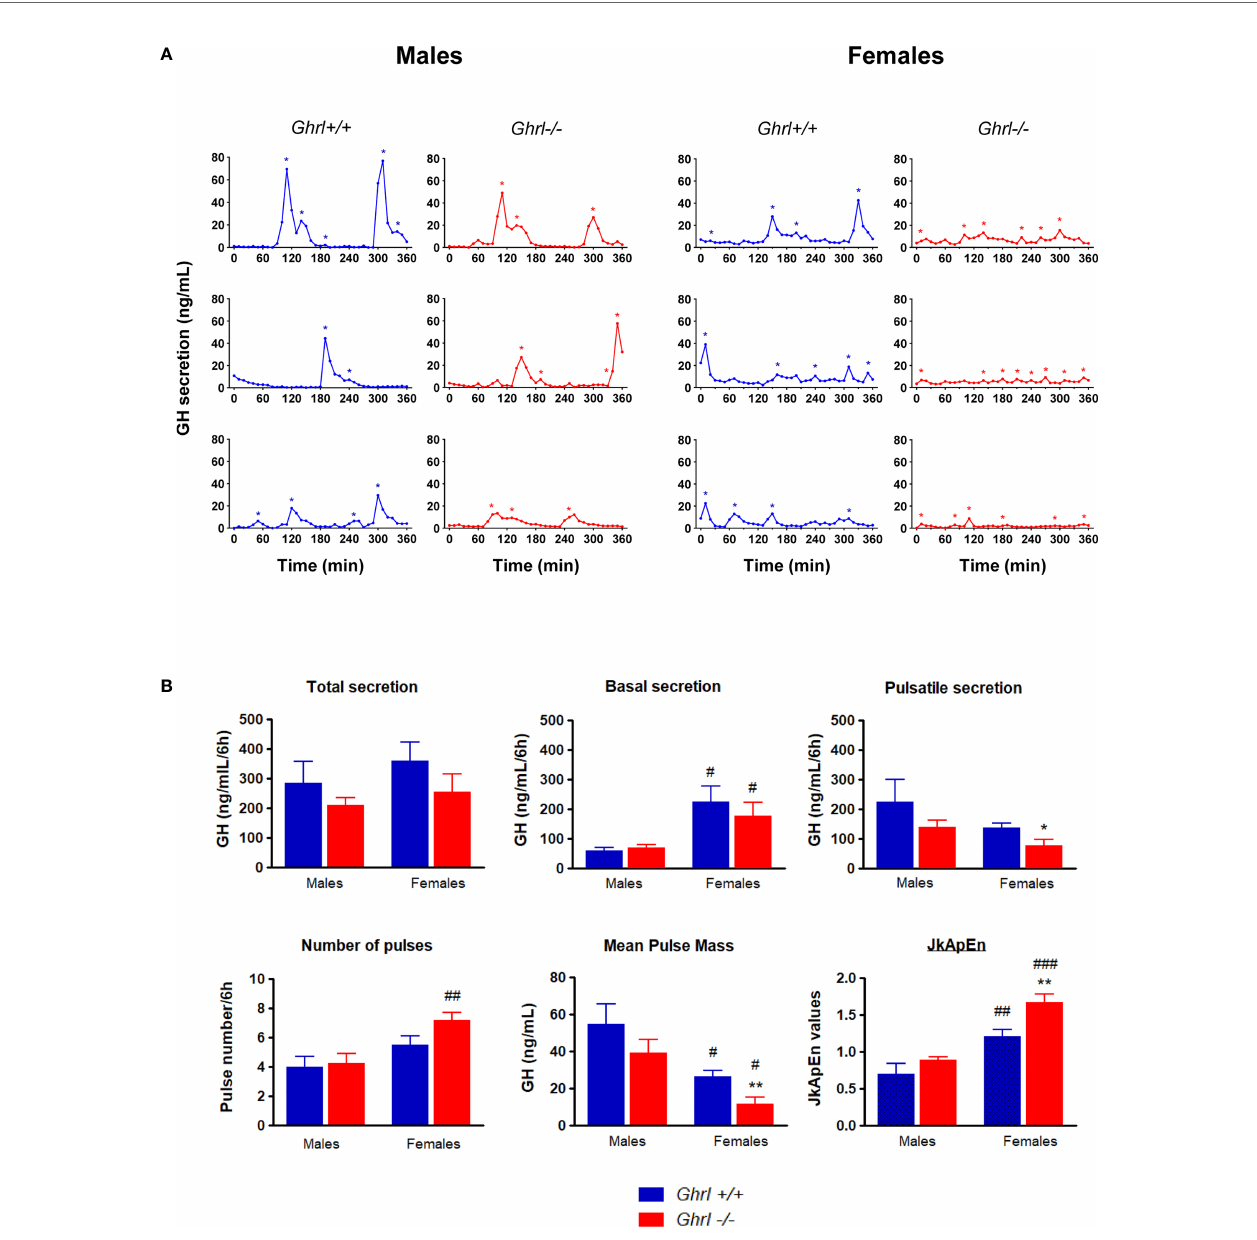
FIGURE 2 | Analyses of ultradian GH secretion in male and female Ghrl-/- mice. Representative individual plasma GH secretory pro fi les in 36-week-old male and female Ghrl+/+ and Ghrl-/- mice (A) . Deconvolution analyses and regularity parameters in adult Ghrl+/+ and Ghrl-/- male and female mice showing total GH secretion, basal GH secretion, pulsatile GH secretion, number of pulses, mean pulse mass and JkApEn values (B) . Asterisks indicate the location of secretory peaks. Data represent mean ± SEM. Number of mice: males (n=5 Ghrl+/+ males and 8 Ghrl-/- ), females (n=8 Ghrl+/+ and 6 Ghrl-/- ). *p < 0.05, **p < 0.01 Ghrl-/- versus Ghrl+/+ mice of the same sex. # p < 0.05, ## p < 0.01, ### p < 0.0001 females versus males of the same